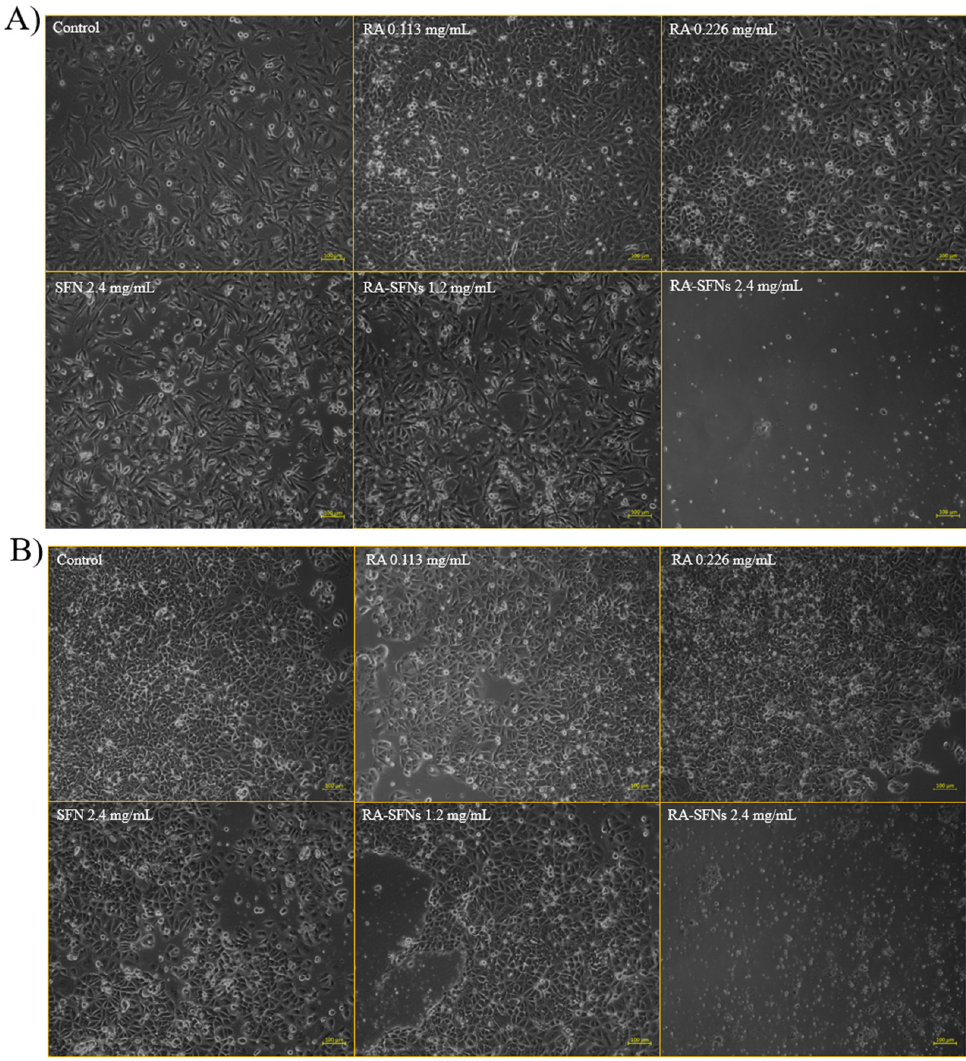
Figure 9. Morphology of ( A ) HeLa and ( B ) MCF-7 cell lines treated with free RA, SFNs and RA- SFNs, and a control (20×). and a control (20 ×